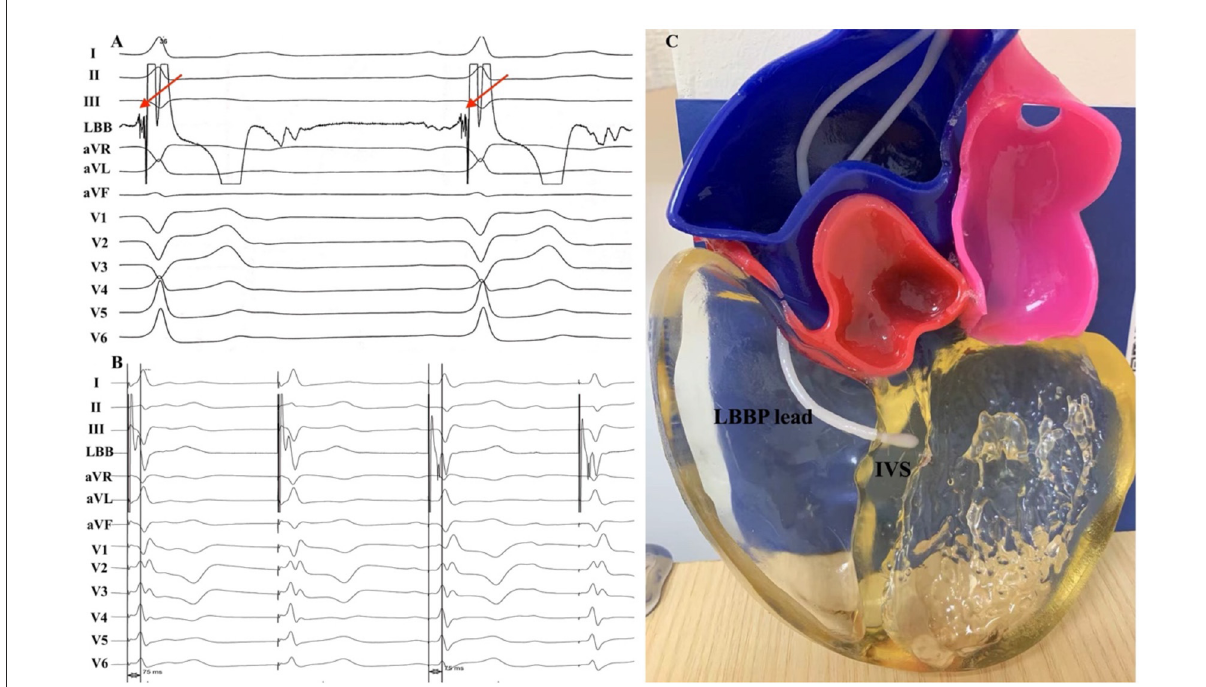
FIGURE1 (A) 12-lead ECG and unipolar tip electrode electrogram obtained during sinus rhythm and (B) LBBP. (C) Three-dimensional printed model. (A) A LBB potential (red arrow) was recorded during the implant procedure. (B) During the threshold test, a transition from non-selective to selective LBBP was observed with a stable peak LV activation time of 75ms. LBB, left bundle branch; LBBP, left bundle branch pacing; LV, left ventricular; IVS, interventricular